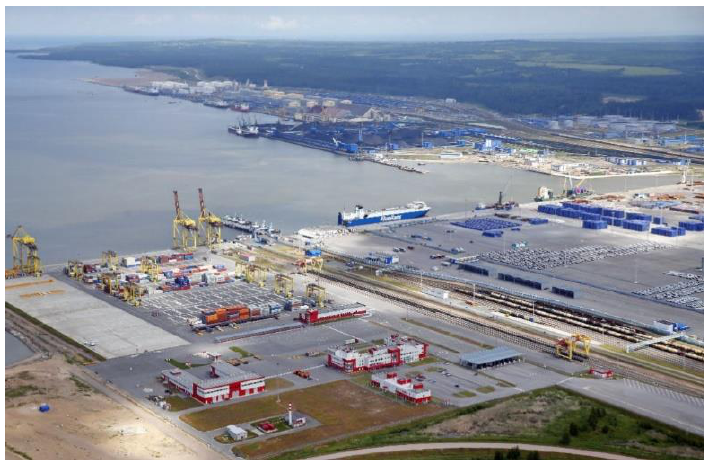
Figure 8. Port of Ust Luga. Source: [76].